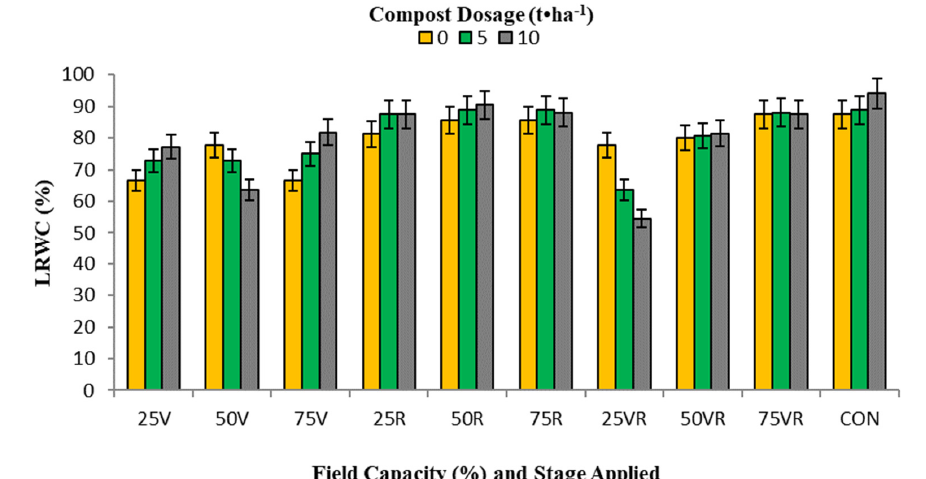
Figure 1. Effect of interaction of water regime, treatment stage and compost dosage on leaf relative water content (LRWC) at 4 weeks